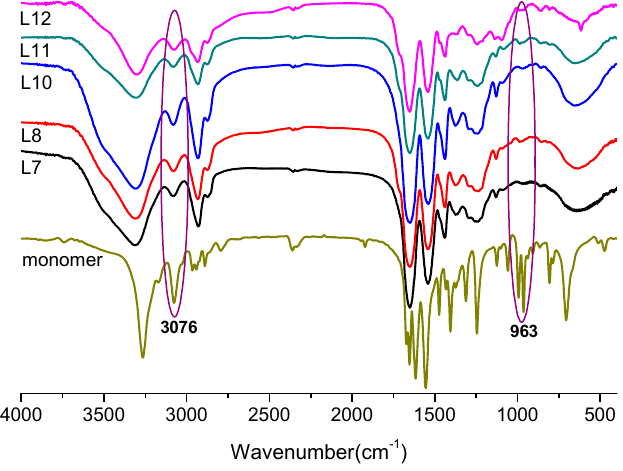
Figure 5. FTIR spectra of monomer and hyperbranched polymers.